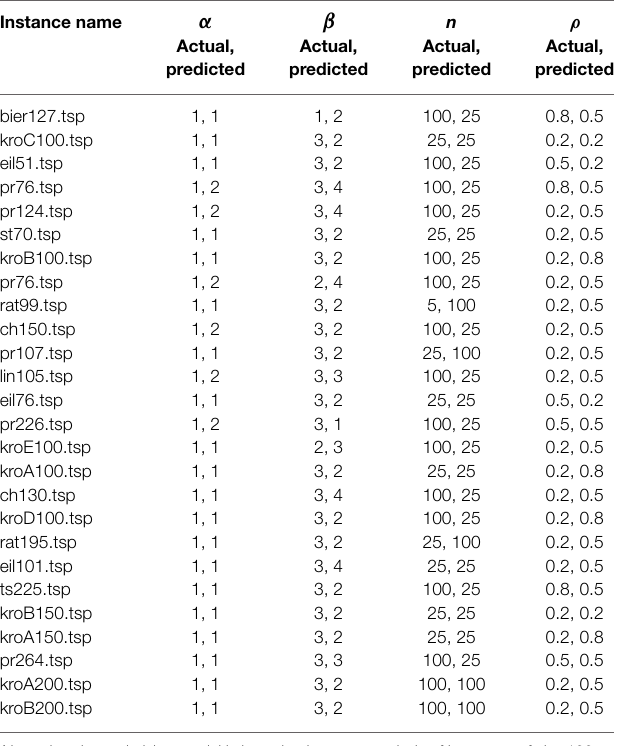
TABLE 5 | Predicted and actual best parameter settings ( (cid:11) , (cid:12) , n , and (cid:26) ) for 26 TSPLIB instances of size in range 51–264 from the prediction model 2a .